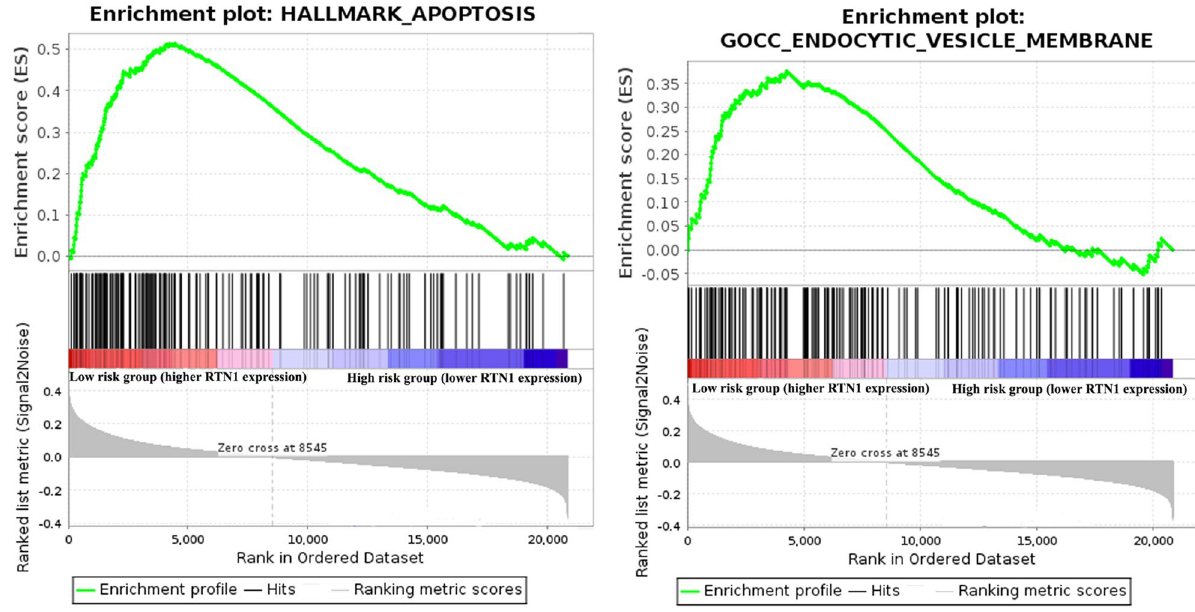
Figure 6. Representative gene set enrichment analysis (GSEA) indicating the enrichment of HALLMARK_ APOTOSIS and GOCC_ENDOCYTIC_VESICLE_MEMBRANE gene sets in low-risk group (higher RTN1 expression) in GSE10846 ( Ps < 0.05). Statistics of GSEA for other datasets were provided in the Supplementary Table 4.